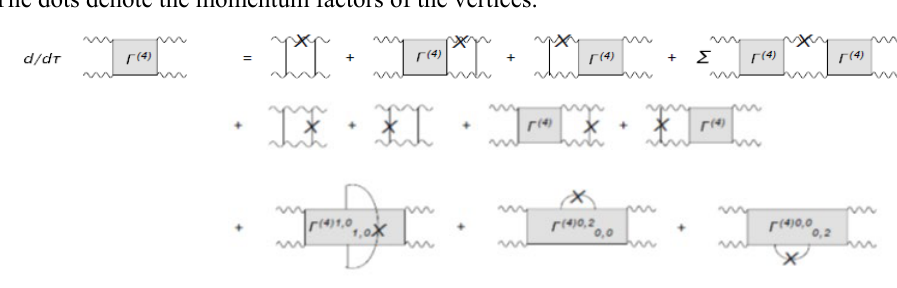
Fig. 3. Diagrammatic representation for the RG flow equation for the 1 PI 4-point function. The crosses mark the derivative of the momentum regulator and the internal wave-line describe the regulated